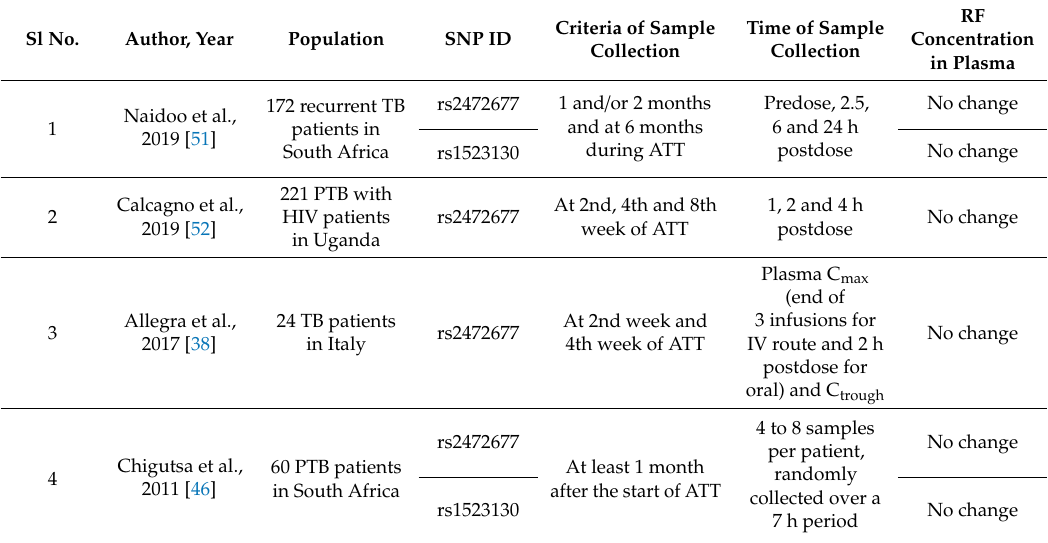
Table 3. Influence of PXR genetic variants on plasma RF levels.